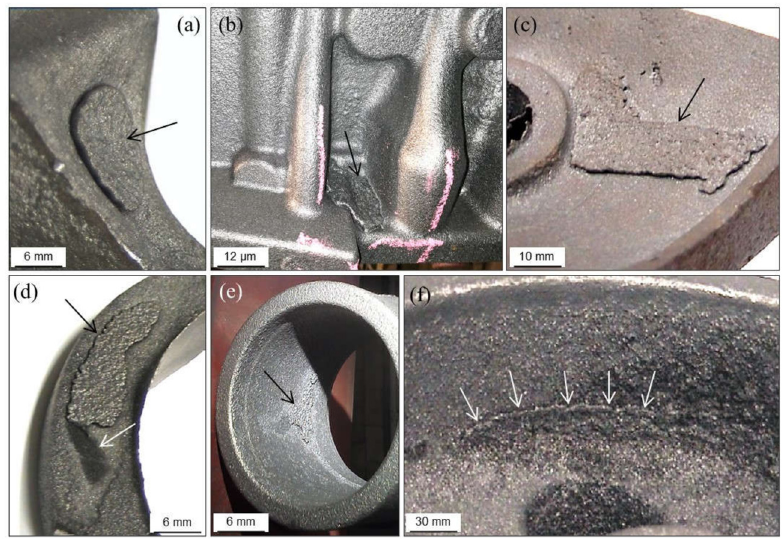
Figure 23. Examples of common scabbing with different appearances: ( a ) rounded scab; ( b , c , e ) scabs with irregular crusts; ( d ) partially broken scab showing sand remnants adhering to the inner surface and ( f ) one-side scabbing in a casting surface with relevant calcination.